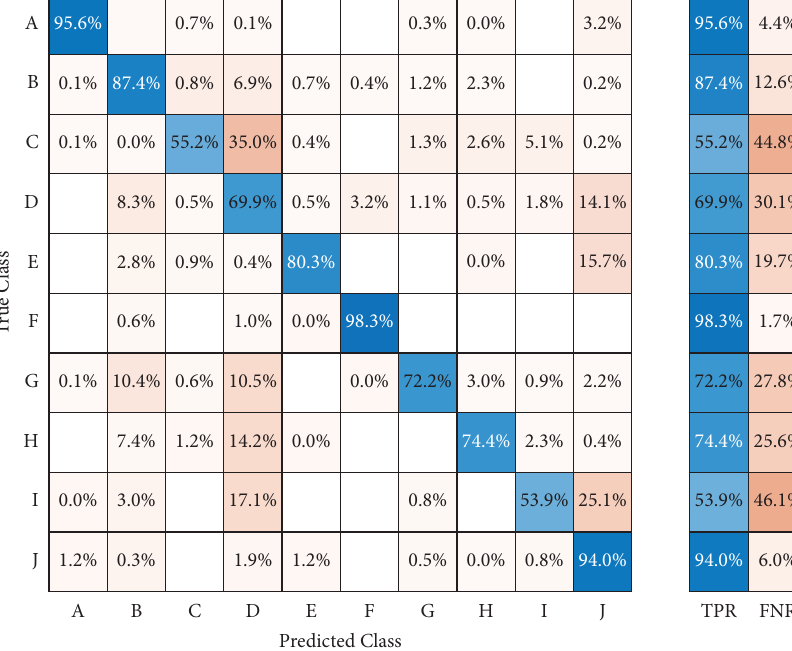
Figure 11: Confusion matrix with TPR vs. FNR for 15-feature model.